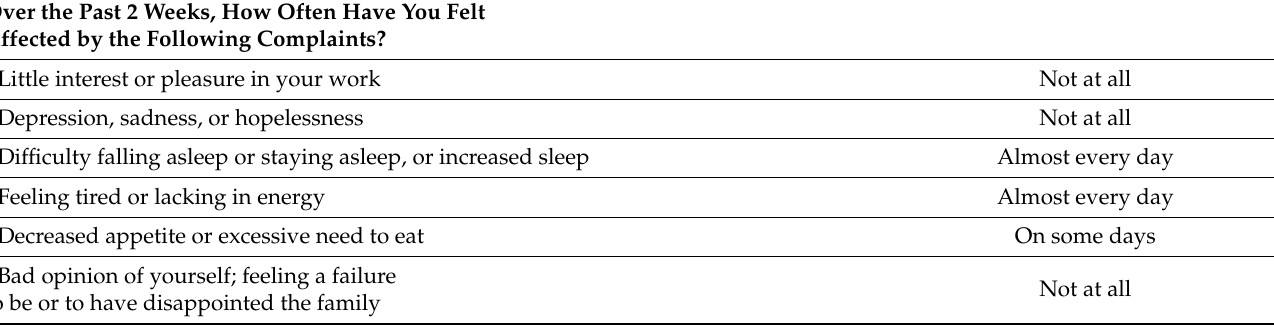
Table 1. Detailed answers on psychological well-being at the time of admission (Patient Health Questionnaire